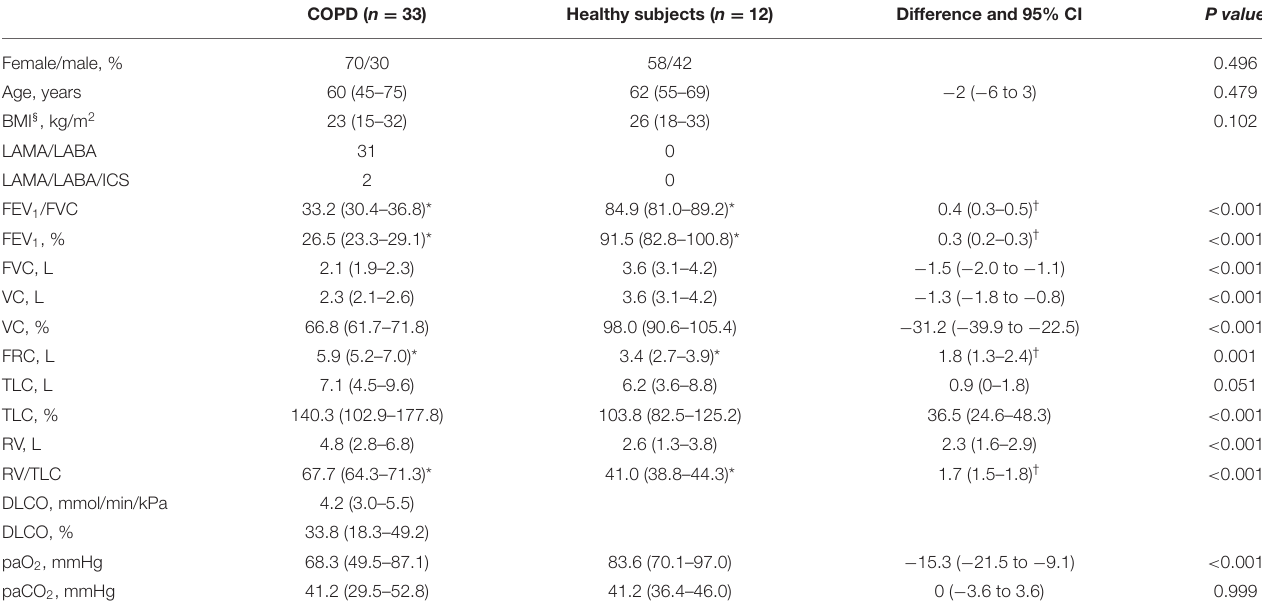
TABLE 1 | Baseline characteristics are indicated as arithmetic means with 95% confidence intervals (CI), except * as geometric means with 95% CI. COPD ( n = 33)